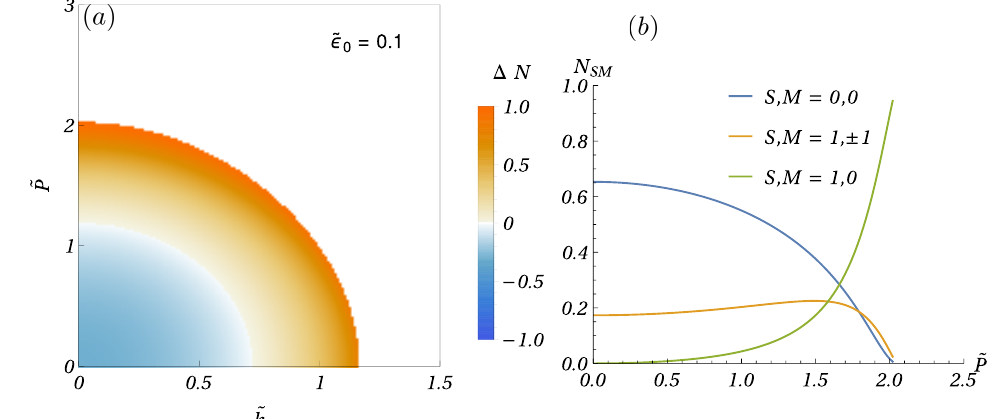
Figure 5: Bound-state triplet admixture for dimers with finite center-of-mass mo- (cid:80) − N N mentum P . Panel (a) shows the quantity ∆ N = , which measures the 1 M 00 M balance between triplet and singlet character in the 2D-fermion dimer, as a func- tion of dimensionless COM-momentum magnitude ˜ P ≡ | P | / ( m λ ) and dimensionless Zeeman energy ˜ h ≡ h / ( m λ 2 ) . The relative weights N of individual total-spin SM eigenstates contributing to the bound-state wave function are plotted in panel (b) as a function of ˜ P for fixed ˜ h = 0, which is the parameter range along the vertical axis in panel (a). Data shown here were calculated for fixed dimensionless interaction ≡ ε / ( m λ 2 ) = strength ˜ ε 0 0